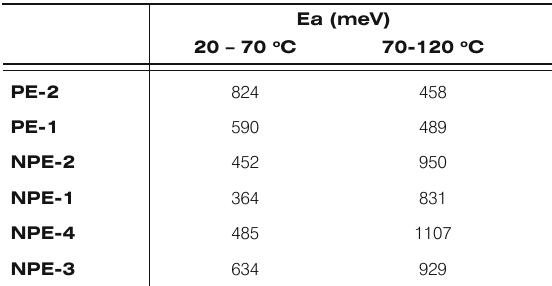
Figure 10. AC conductivity of A) PE1 B) PE2 C) NPE-1 D) NPE-2 E) NPE-3 F) NPE-4 Table 2. The obtained E for A) PE-1 B) PE-2 C) NPE-1 D) NPE-2 A E) NPE-3 F) NPE-4 below and above70 o .